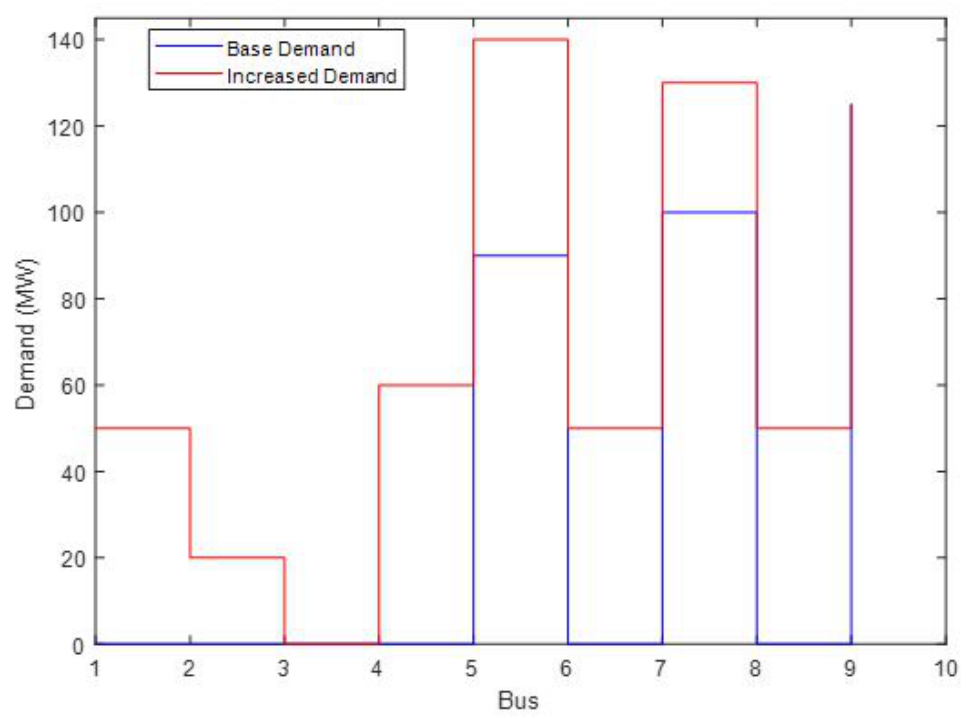
Figure 3. The 9-bus system’s load profile in base and increased demand scenarios.